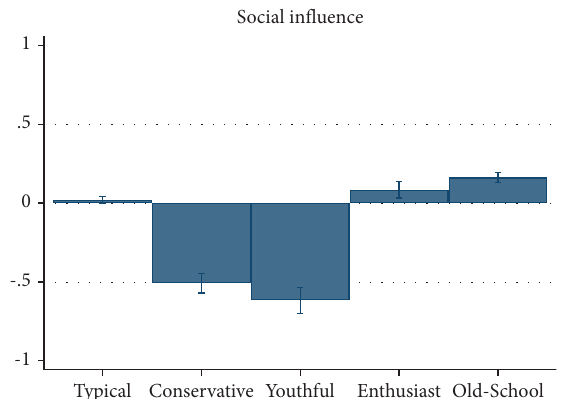
Figure 4: Social latent construct: social infuences. Latent factor scores on vertical axis. Tree items used for generating the SI-latent construct: it is assumed that people whose opinions is valued would prefer that a CAC is used; it is expected that people who infuence behaviour think that a CAC should be used; it is expected that people who are important think that a CAC should be used.